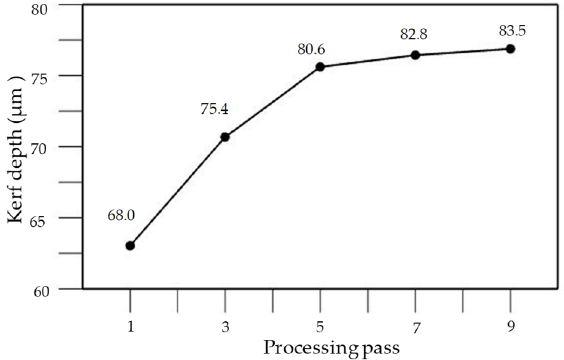
Figure 9. Relationship between number of cutting passes and kerf depth (laser processing parameters were set at average power of 25.5 W, pulse width of 200 ns, and repetition rate of 170 kHz). Table 5. Lowest pulse repetition rates for specific pulse widths. The maximum pulse energy and maximum peak power are also